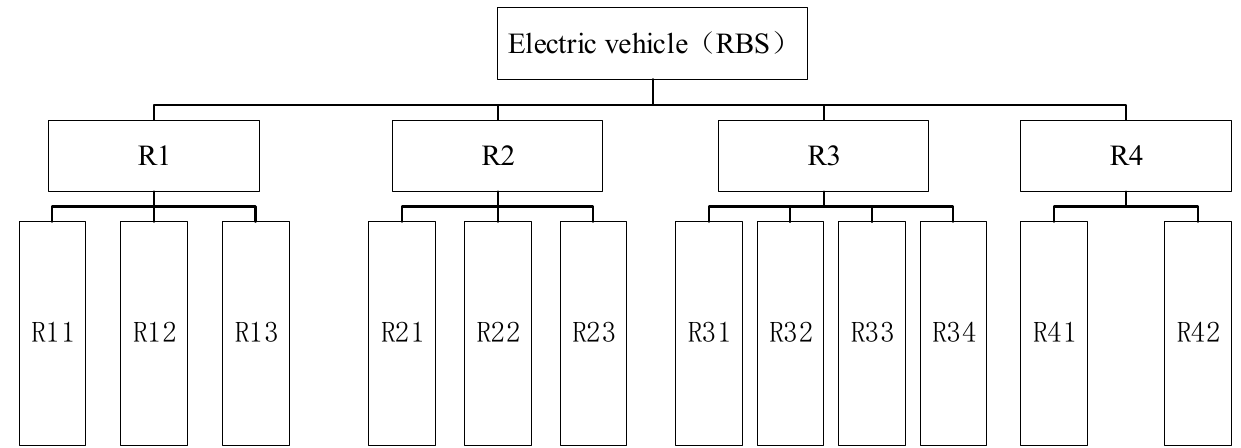
Figure 7. Electric vehicle WBS decomposition structure tree.